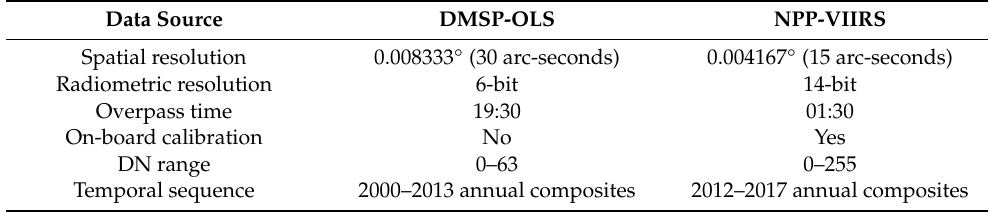
Table 1. The di ff erences between raw Defense Meteorological Satellite Program’s Operational Linescan System (DMSP-OLS) and Visible Infrared Imaging Radiometer Suite carried by the Suomi National Polar-Orbiting Partnership (NPP-VIIRS)